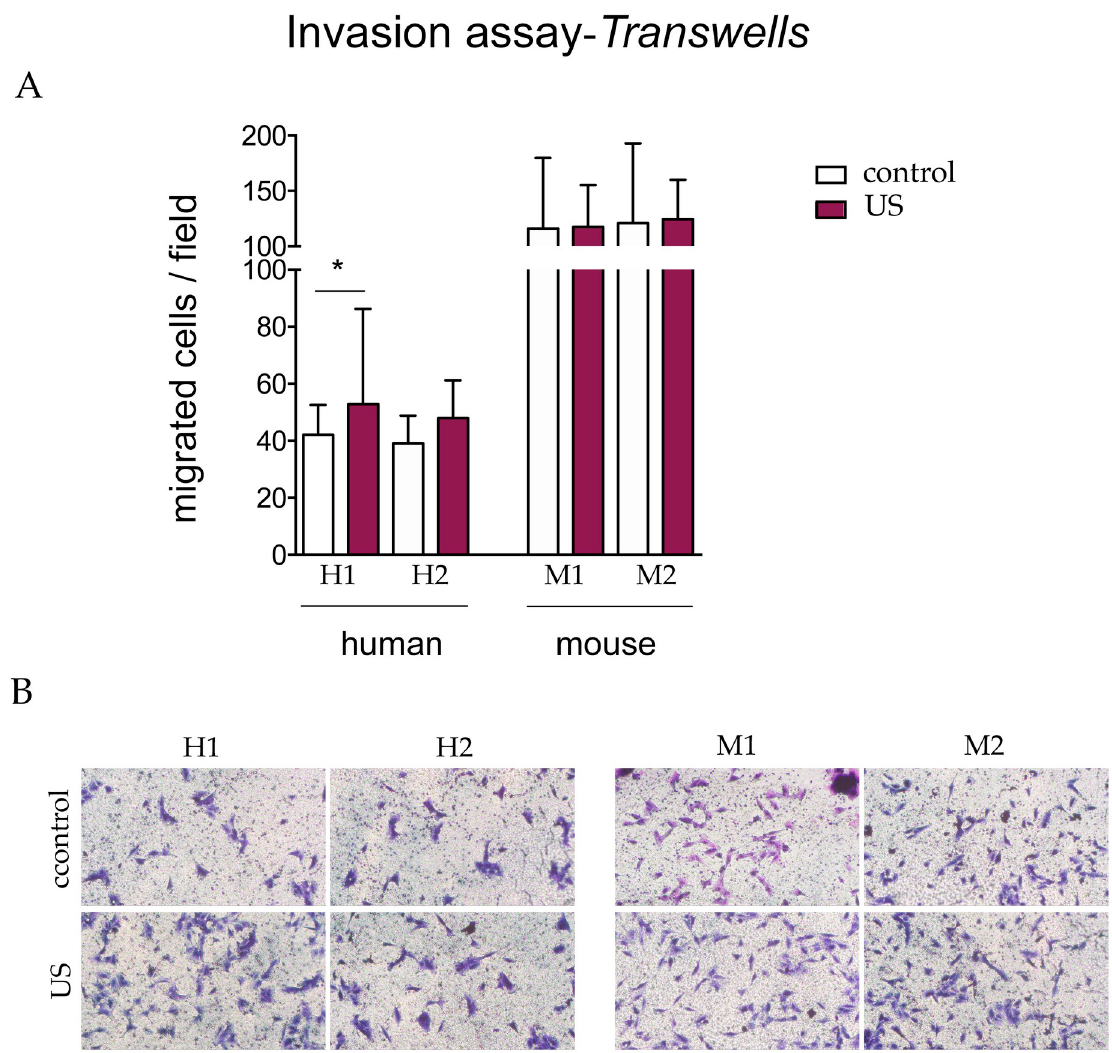
Fig 7. Transwell invasion assay. (A) Data are shown from a representative experiment out of three performed and denote mean ± SD. Statistical analysis was performed using Student’s t test. � p < 0.05. (B) Representative images (10 × ) of the migrated cells. Shown are two independent samples of mouse (M1 and M2) and human (H1 and H2) s-MPs under control conditions or treated with ultrasound